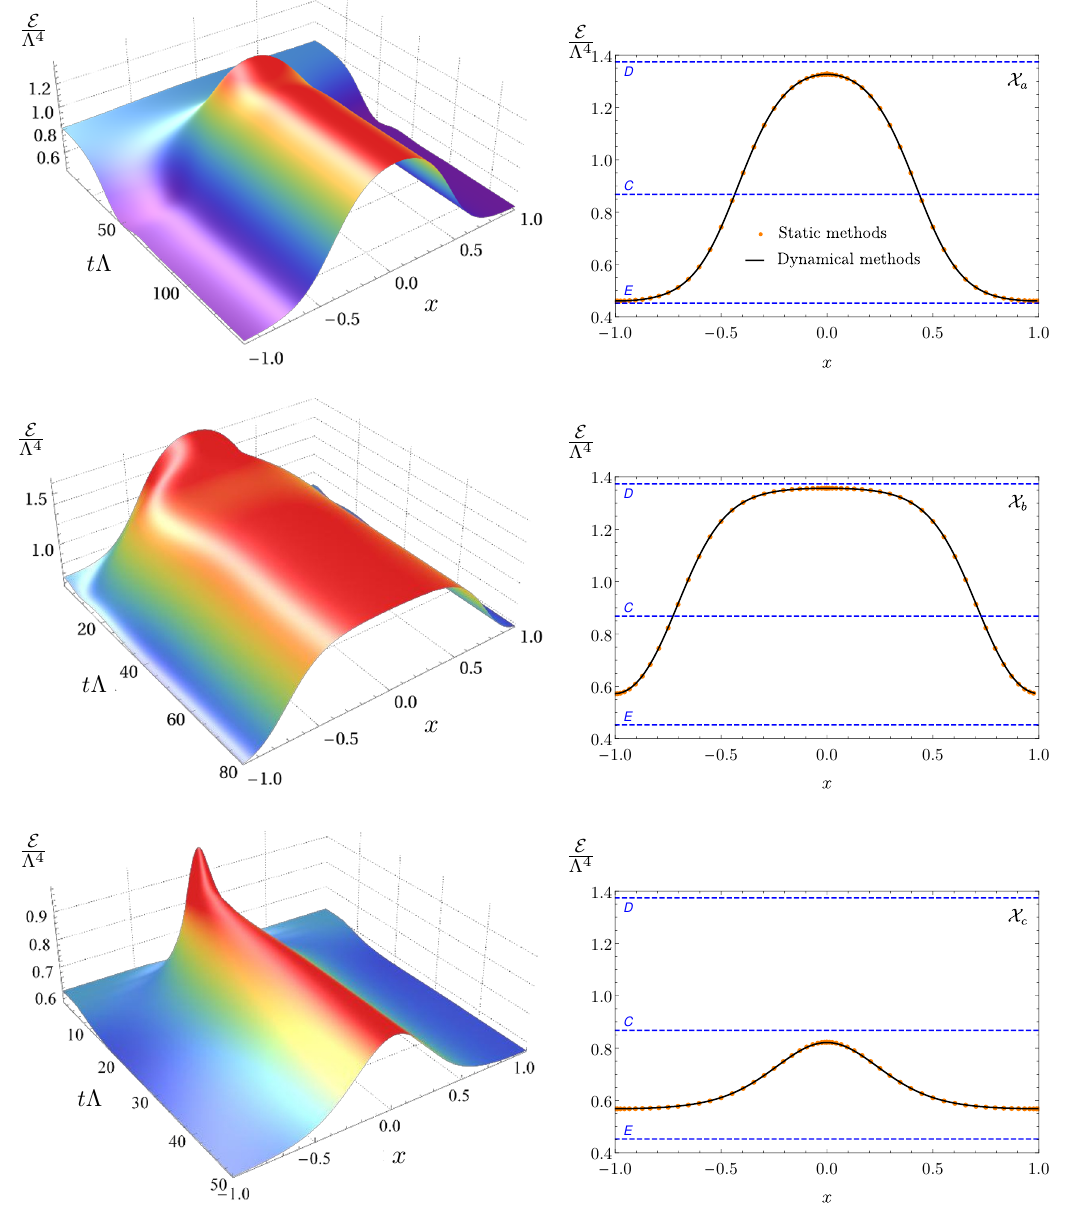
Figure 24 . Real-time evolution leading to a type I (top-left), a type II (middle-left) and a type III (bottom-left) lumpy brane with ˆ L ’ 11 . 501849 , labelled X a , X b and X c in figure 22, respectively. On the right panels we compare the energy density profiles at late times (continuous black lines) with those obtained by static methods (orange